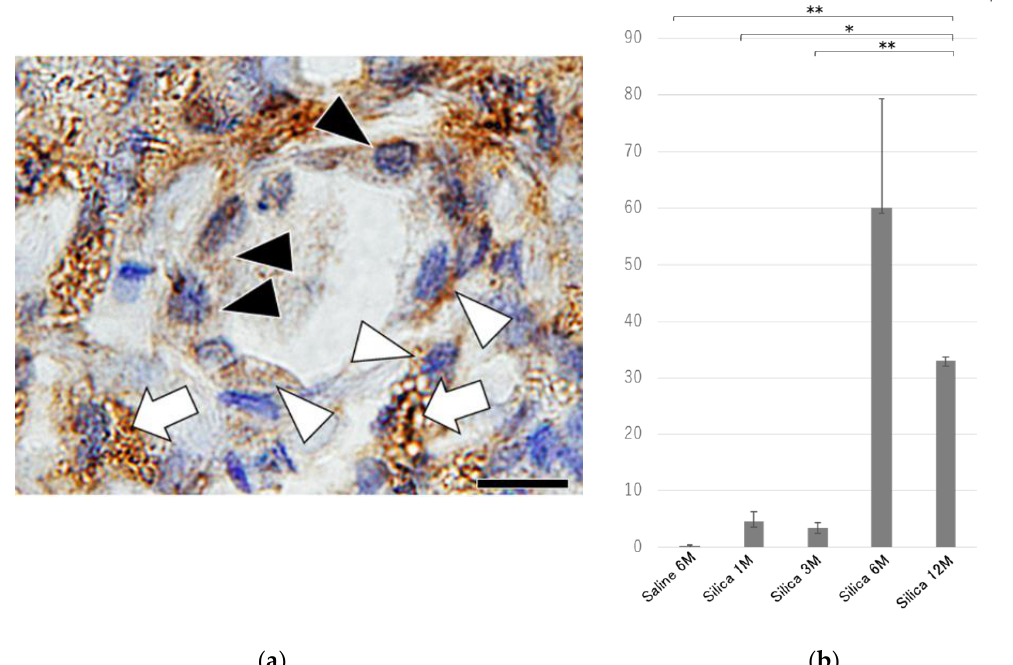
Figure 6. ( a ) Microscopic findings of the fibrotic lesion of the lung tissue at 6 months after silica treatment, showing TGF- β positive labelling in macrophages (white arrows), hyperplastic epithelial cells (black arrow heads) and spindle cells (white arrow heads). TGF- β immunohistochemistry. Bar = 20 μm , and ( b ) semiquantitative analysis of the immunohistochemical reactions of TGF- β in the lung tissues. Increase in the number of TGF- β positive cells is shown in the treated lungs. All data are expressed as mean ± SD. Statistically significant differences (* p < 0.05, ** p < 0.01) are indicated. Western blotting revealed upregulation of TGF- β and α -smooth muscle actin proteins after silica exposure in a time-dependent manner (Figure 7a,b).